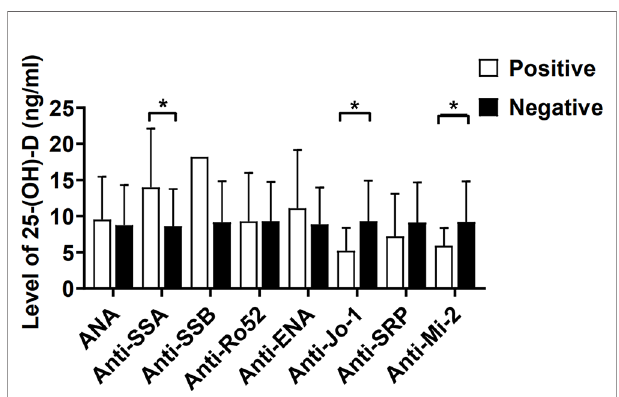
FIGURE 3 | The serum levels of 25-(OH)-D (ng/ml) in IIM patients were compared between autoantibody positive and negative. ANA, Antinuclear antibody; SSA, Sjögren ’ s syndrome antigen A; SSB, Sjögren ’ s syndrome antigen B; Anti-Jo-1, anti-histidyl-tRNA synthetase; SRP, signal recognition particle. *p < 0.05.